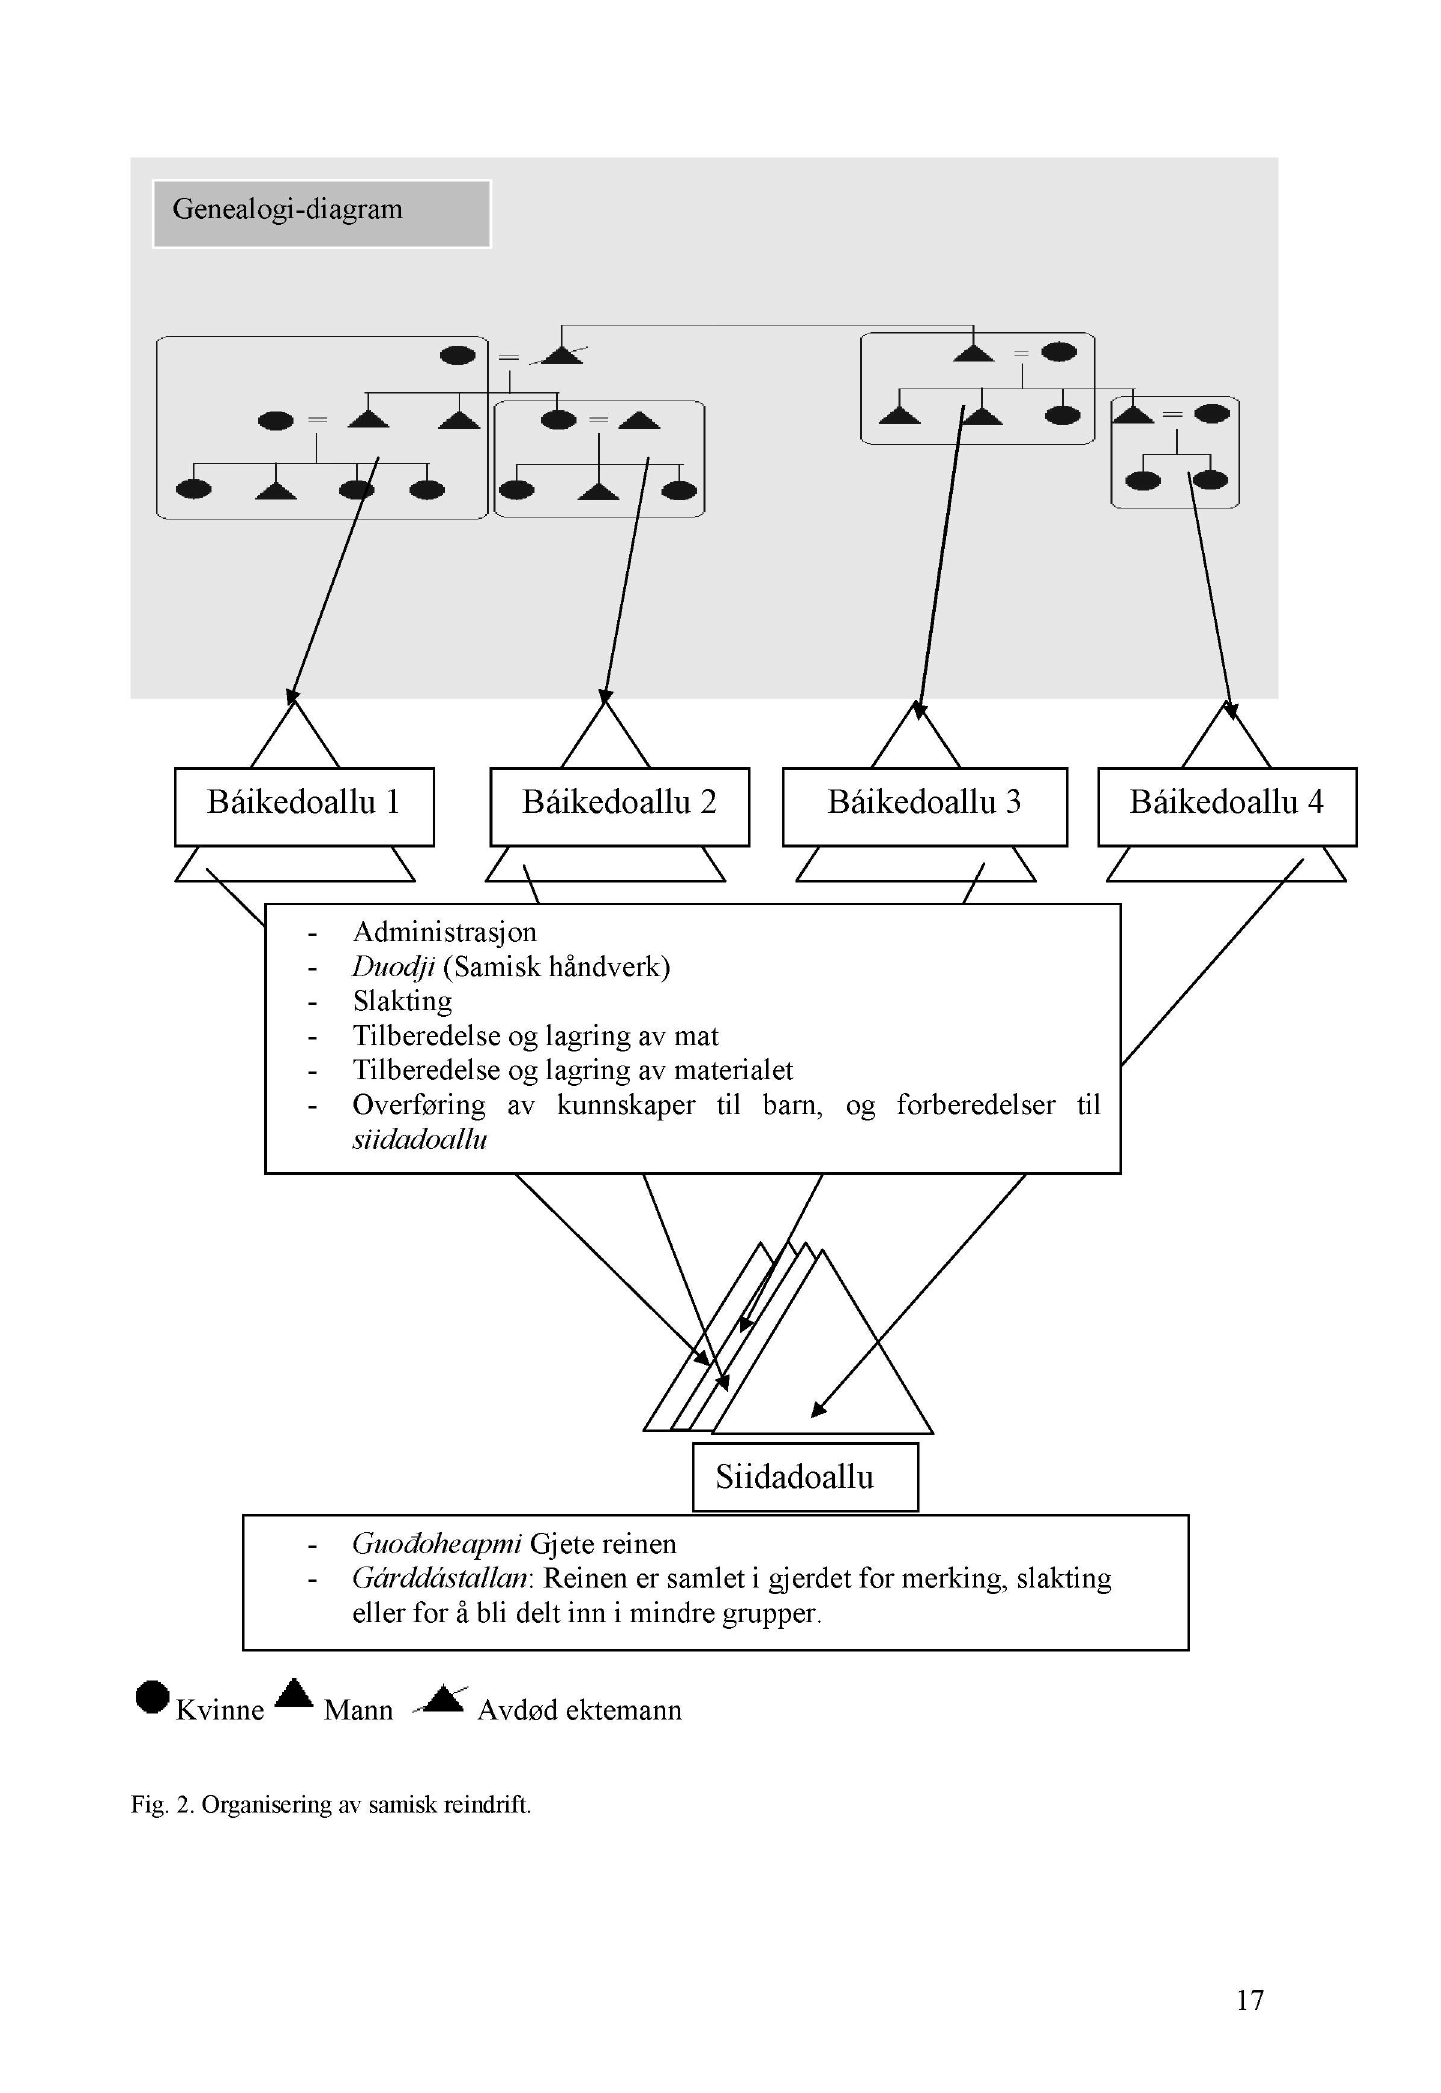
Fig. 2. Organisering av samisk